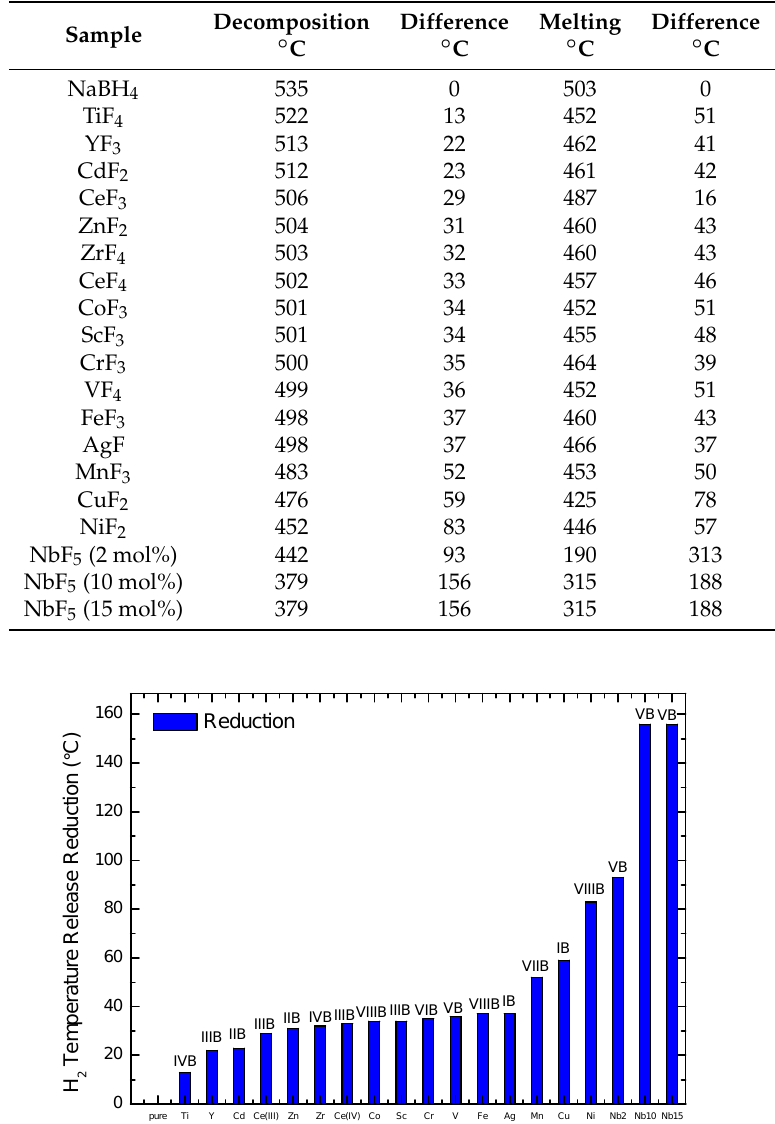
Table 2. TPD temperatures for the main decomposition and melting events of all the samples together with their temperature difference when comparing to NaBH 4 . The tabulated values correspond to the maxima of the measured data in every peak region. The samples are ordered from top to bottom following Figure 2.